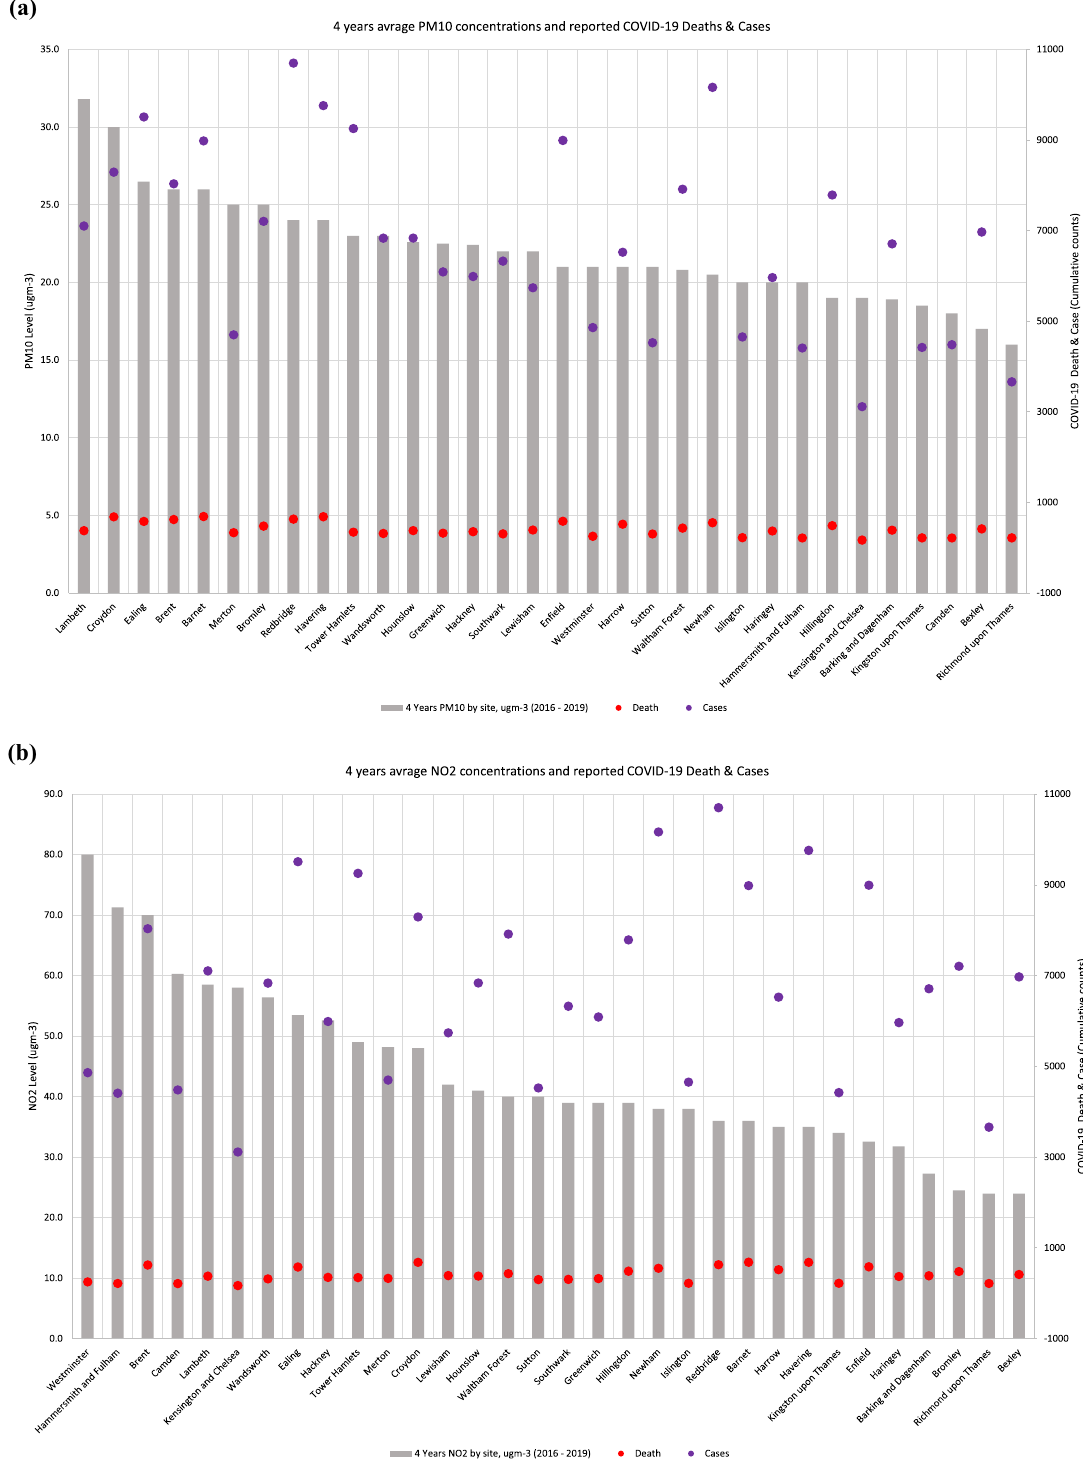
Figure 3. ( a ) Relationship between PM10 (μgm-3) and COVID-19 case and death rate in each London borough. ( b ) Relationship between NO2 (μgm-3) concentrations and COVID-19 case and death rate in each London